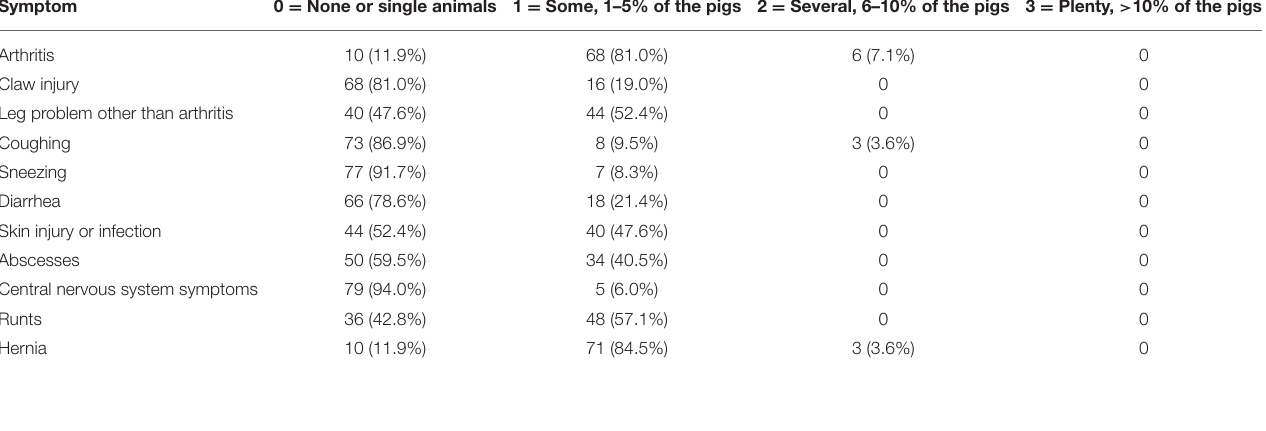
TABLE 5 | The presence of different symptoms in the finishing pigs (number and percentage of herds out of 84) recorded by herd veterinarians during one herd health visit. Symptom